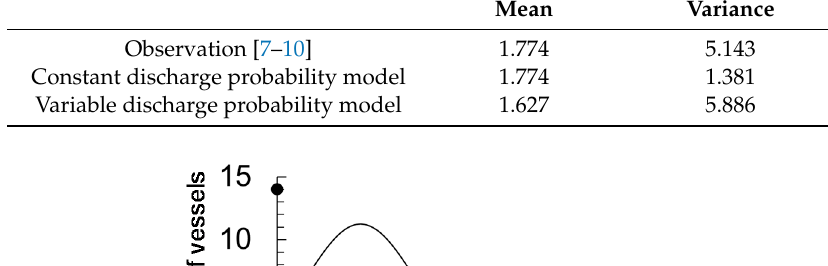
Figure 2. Number of vessels versus amount of discharge. Solid line is from the constant discharge probability model, and closed circles are from observation.